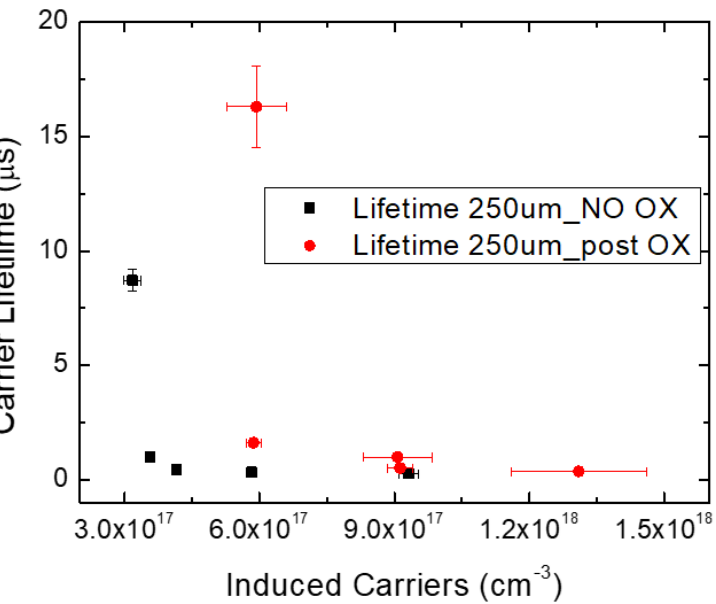
Figure 3. Carrier lifetime as a function of induced carriers, before (NO Ox) and after (Post OX) the oxidation process.